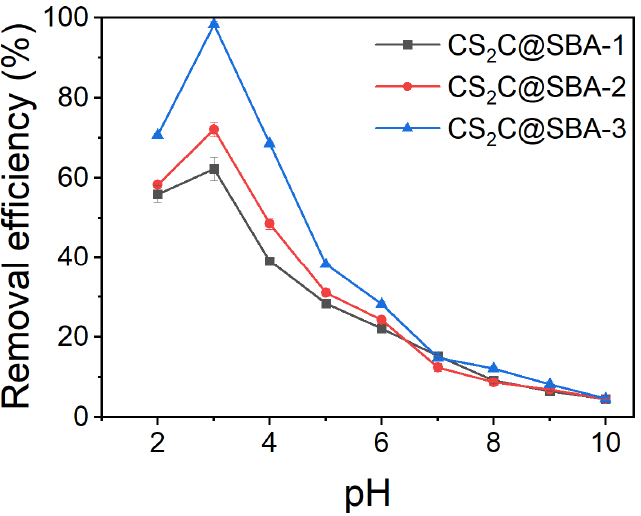
Figure 3. Effects of pH on V(V) elimination. Conditions: V(V) initial concentration = 100 ppm, CS 2 C@SBA dosage = 1.0 g/L, experimental temperature = 298 K, contact time = 24 h.